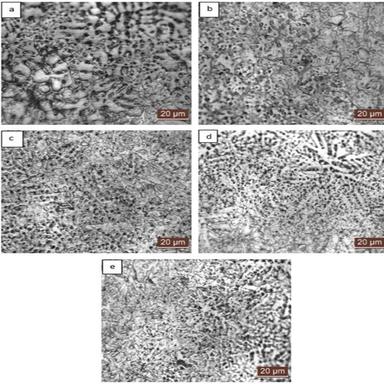
Optical Images (a) AZ31 alloy, (b) AZ31-0.5 B4C, (c) AZ31-1.0 B4C, (d) AZ31-1.5 B4C and (e) AZ31-2.0 B4C.